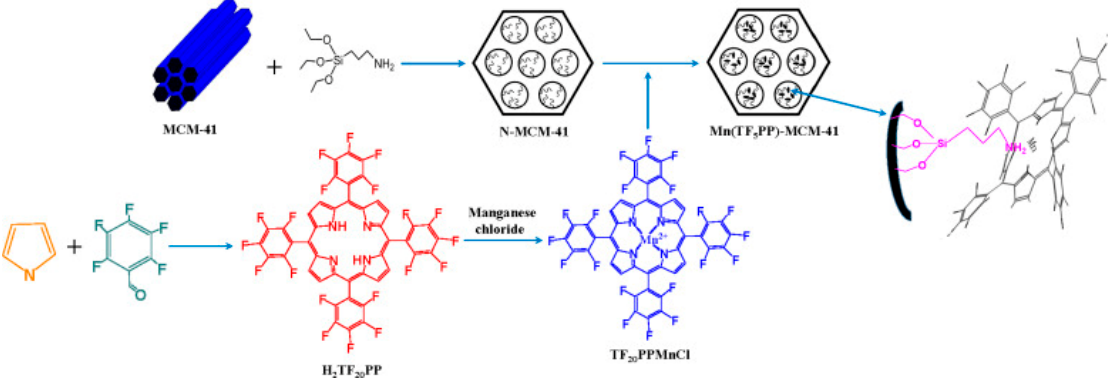
Figure 38. Synthesis of the Mn(TF5 PP)-MCM-41 catalyst. Reproduced with permission from [53]. Copyright 2015 Elsevier B.V.